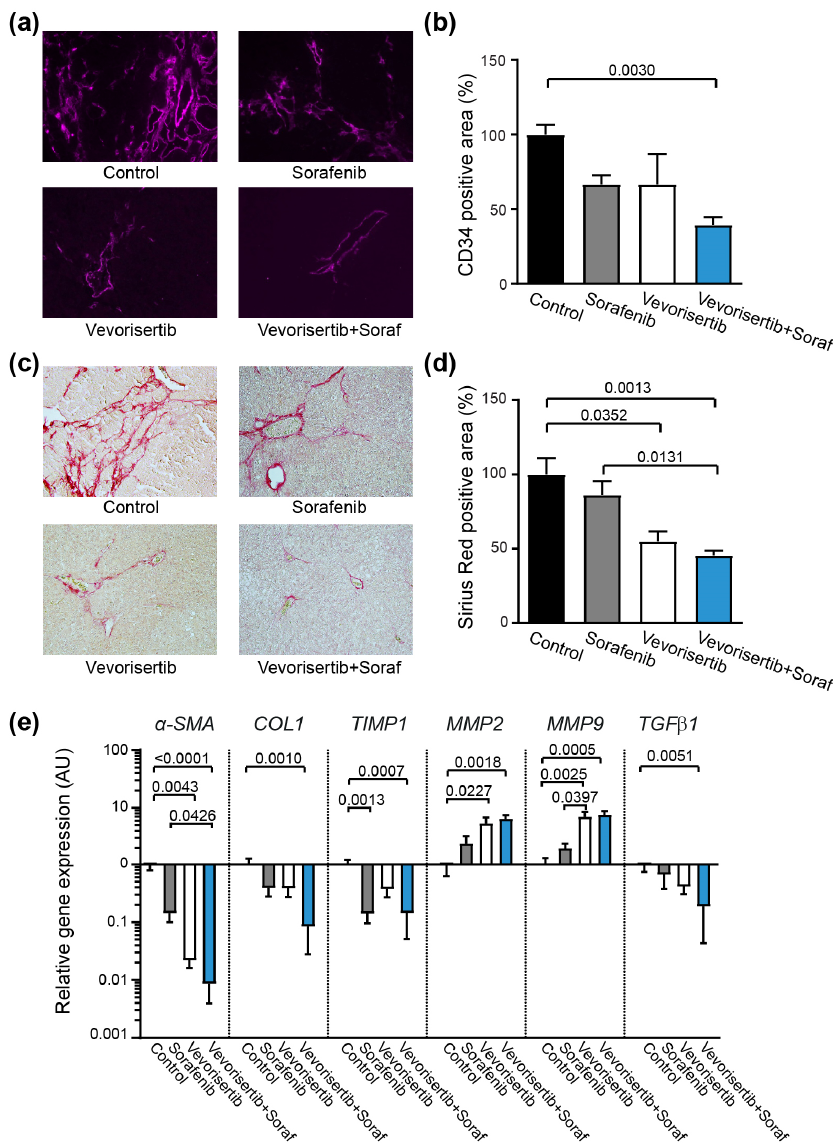
Figure 4. Effect of vevorisertib and vevorisertib + sorafenib treatment on tumor vascularization and liver fibrosis. ( a ) Representative images of CD34 immunofluorescence staining of control, sorafenib, vevorisertib and vevorisertib + sorafenib treated group, 20× magnification, ( b ) quantification of CD34 positive staining area, mean of control group was set as 100%. ( c ) Representative images of liver tissues stained with Sirius red, 20× magnification, ( d ) quantification of Sirius red staining per area, mean of control group was set as 100%. ( e ) Relative gene expression of alpha-smooth muscle tissue ( α -SMA ), collagen 1 ( COL1 ), tissue inhibitor of metalloproteinases 1 ( TIMP1 ), matrix metalloproteinase-2 ( MMP-2 ), matrix metalloproteinase-9 ( MMP-9 ) and transforming growth factor ( TGF- β ) in liver tissue; mean of control group was set as 1. n = 7/group; values are mean ± SE. The Kruskal–Wallis test was used for multiple comparisons.